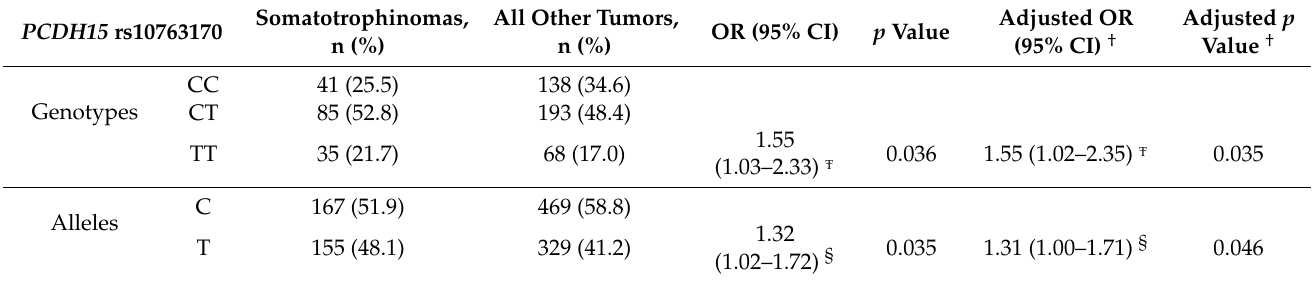
Table 2. Distribution of PCDH15 genotypes and alleles in somatotrophinomas and all other tumors.